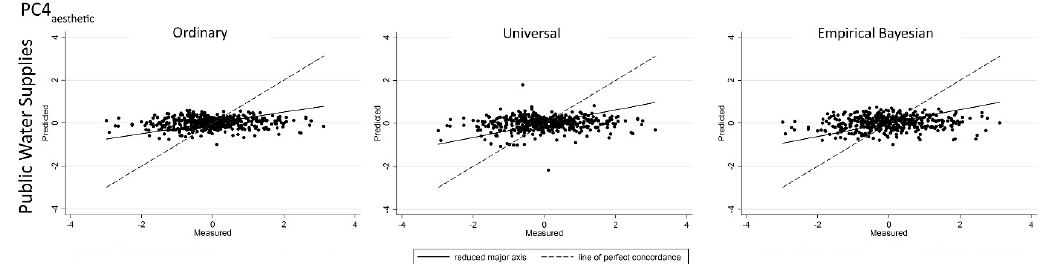
Figure A8. Predicted vs. measured values for PC4 aesthetic scores obtained from the cross-validation results for ordinary, universal, and empirical Bayesian kriging for public water supplies. Line of perfect concordance indicated by dashed line.